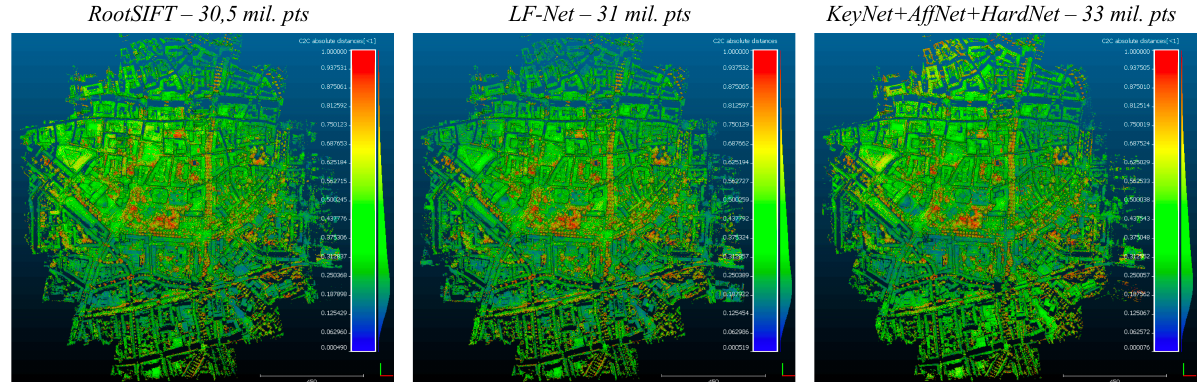
Figure 4: Dortmund dataset - Cloud-to-cloud comparisons of MVS results obtained using the different ATs (RootSIFT, LF-Net, and Key.net). Metrics in Table 3.